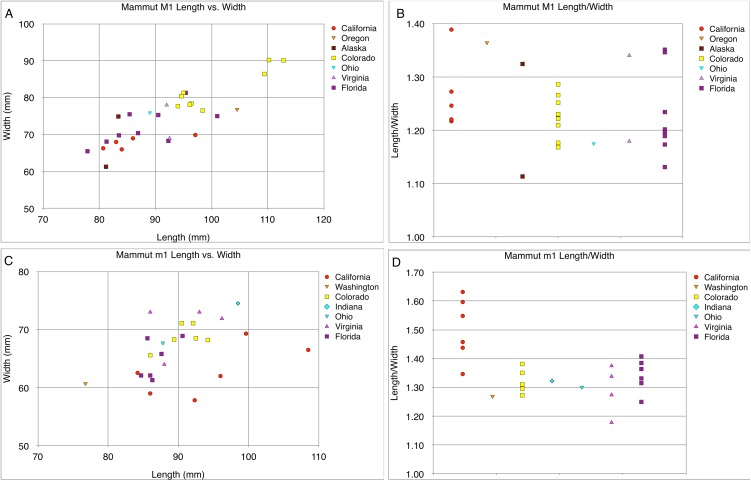
Length and width comparisons of Mammut M1 and m1, by state/province/country.(A) Length vs. width of Mammut M1. M. pacificus is indicated in red, (B) length/width of Mammut M1, organized by location. M. pacificus is indicated in red, (C) length vs. width of Mammut m1. M. pacificus is indicated in red, and (D) length/width of Mammut m1, organized by location. M. pacificus is indicated in red.